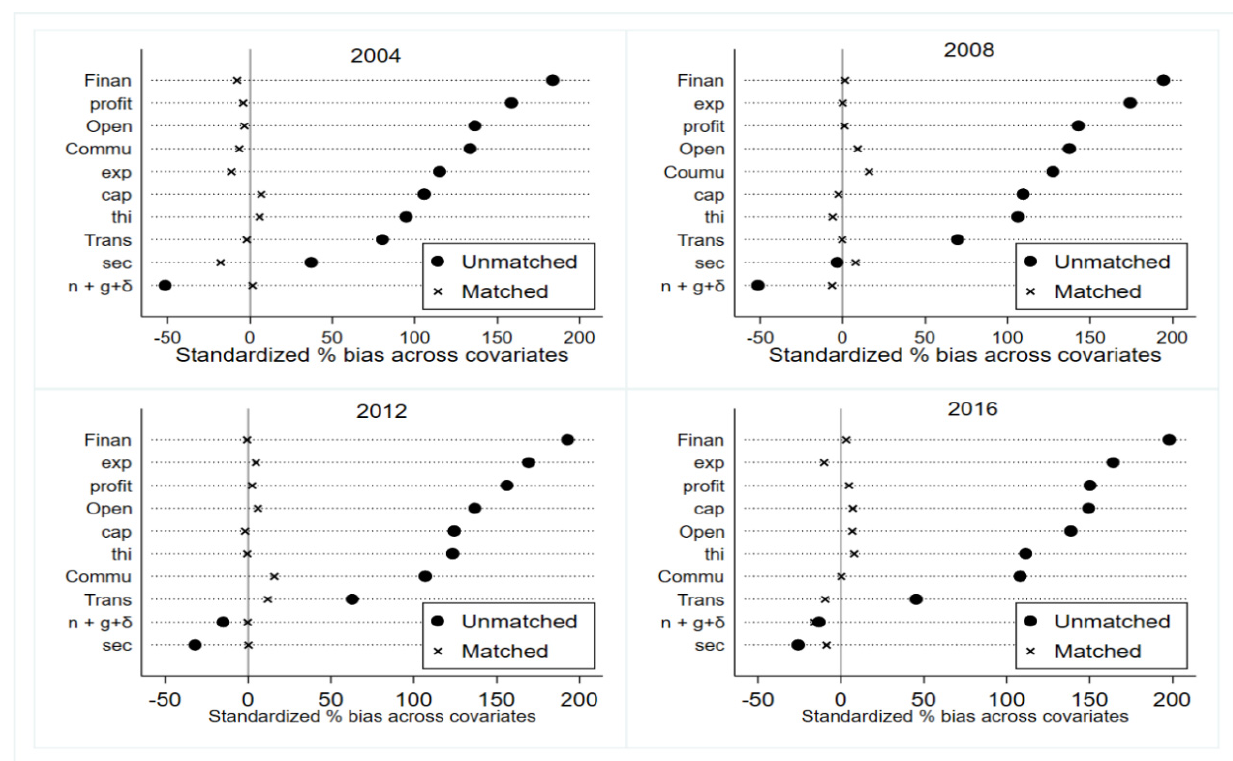
Figure 7. Variable balance in PSM.